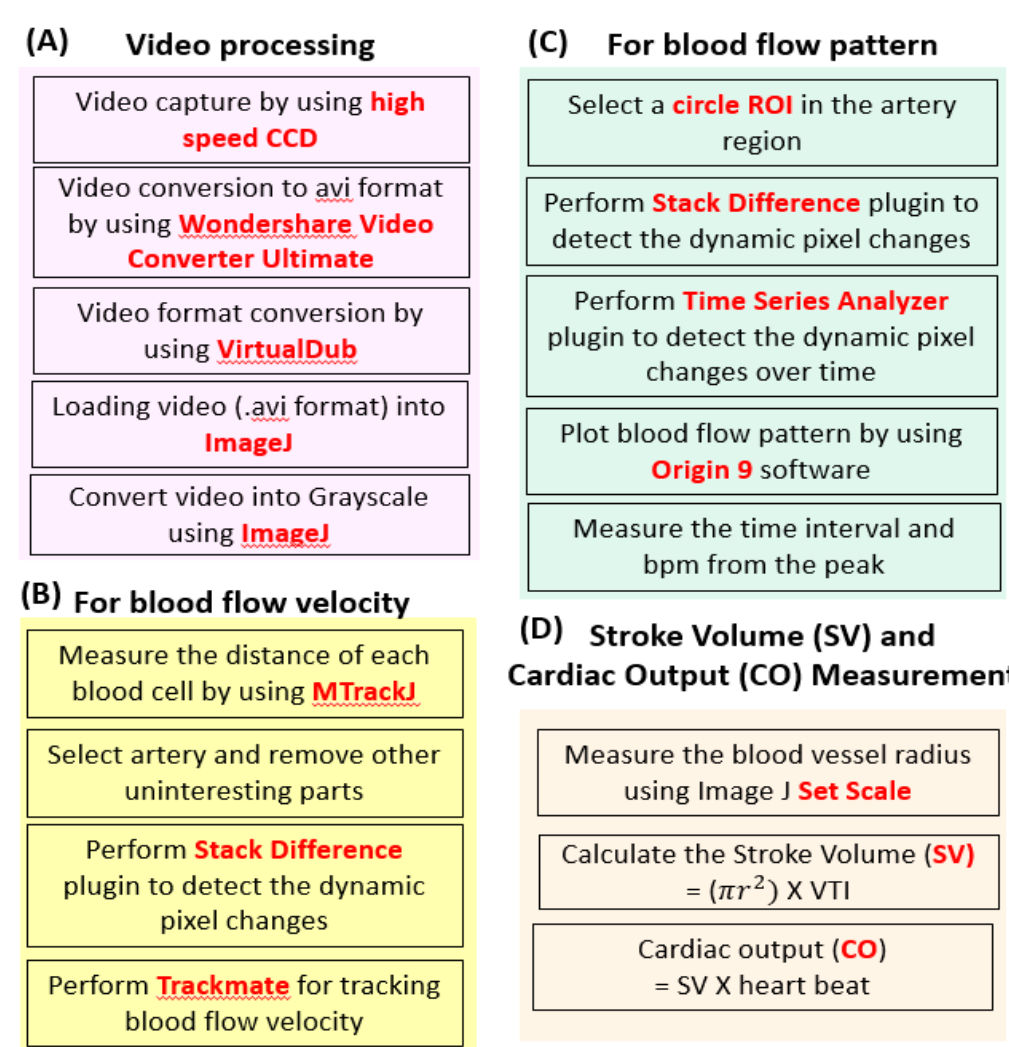
Figure 1. The basic principle for blood flow measurement in zebrafish embryos. ( A ) The experimental scheme for video processing. ( B ) The experimental pipeline of blood flow velocity analysis, blood flow pattern analysis ( C ), stroke volume, and cardiac output measurement ( D ).